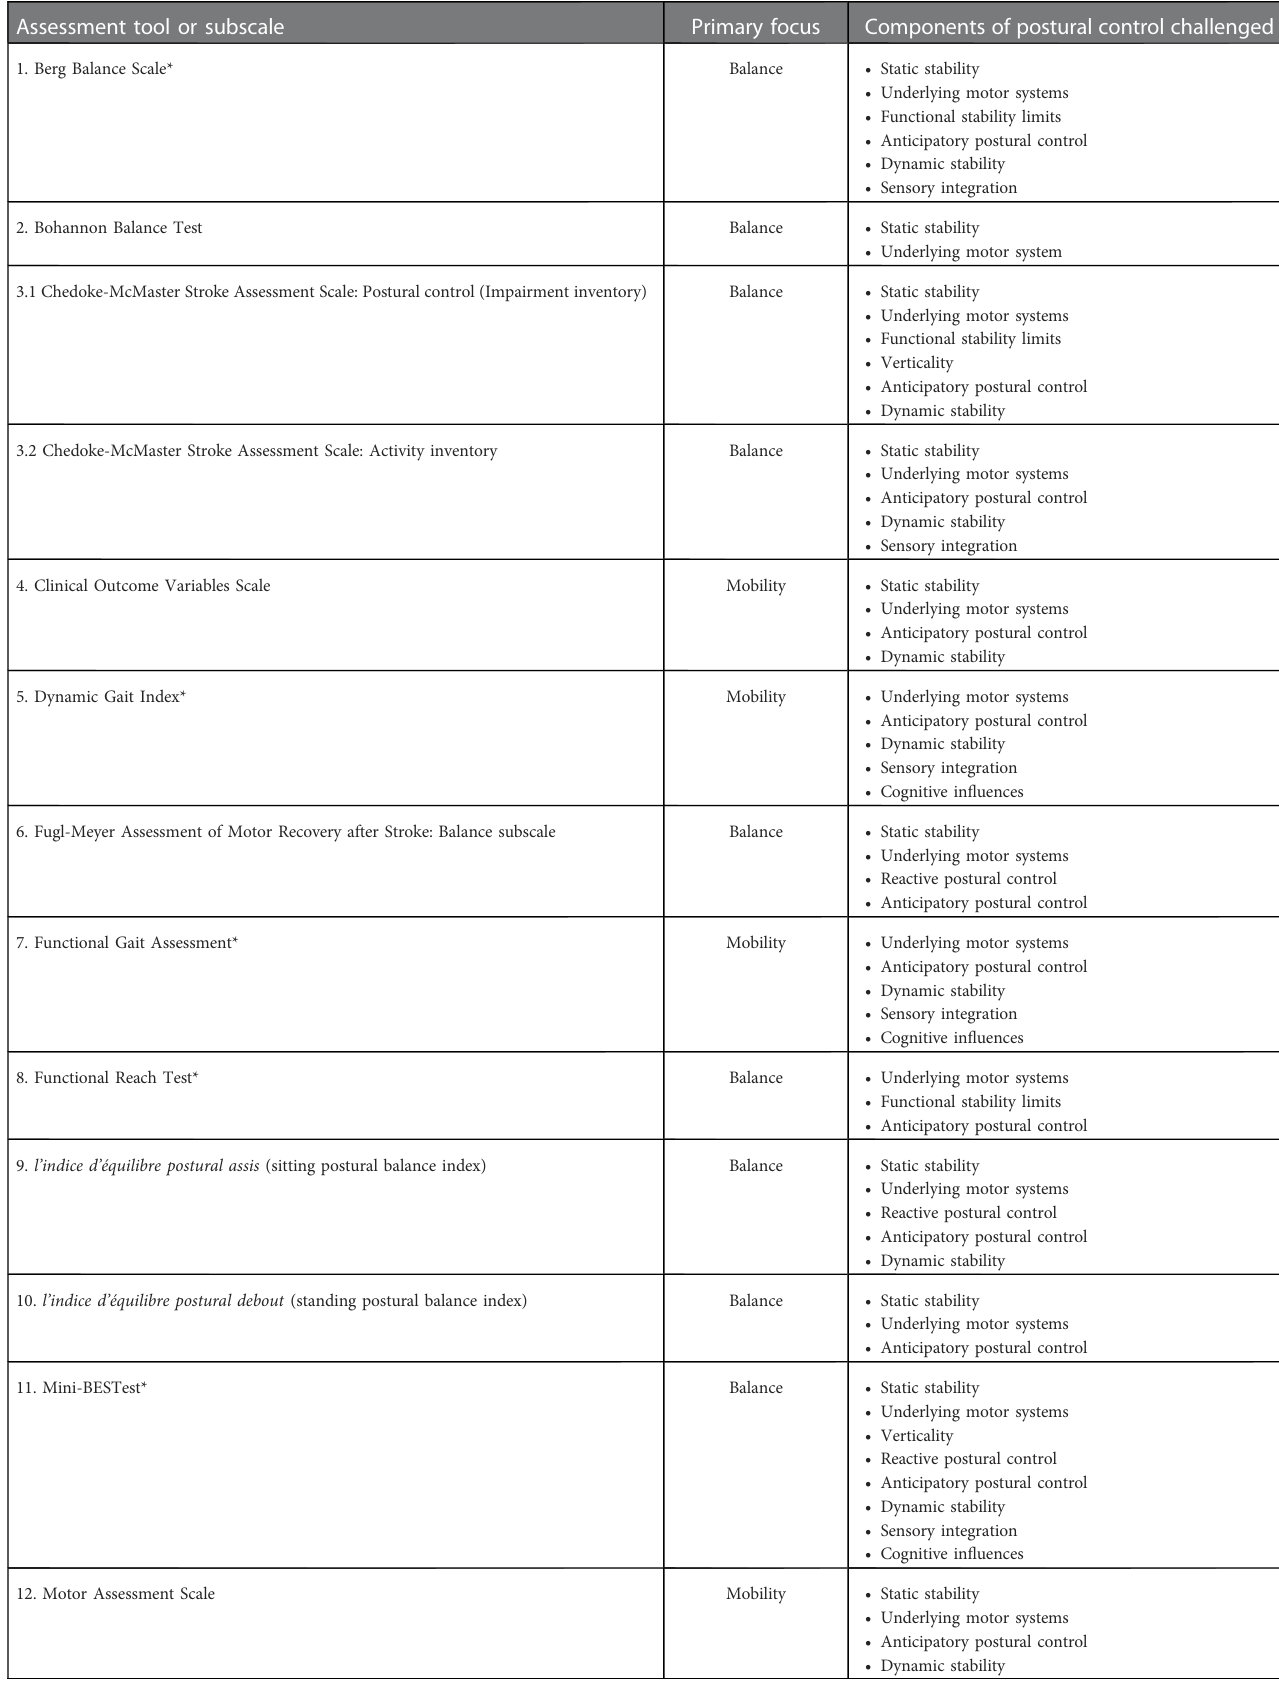
TABLE 3 Primary focus and components of postural control challenged for standardized tools for assessing balance and mobility included in stroke clinical practice guidelines. Assessment tool or